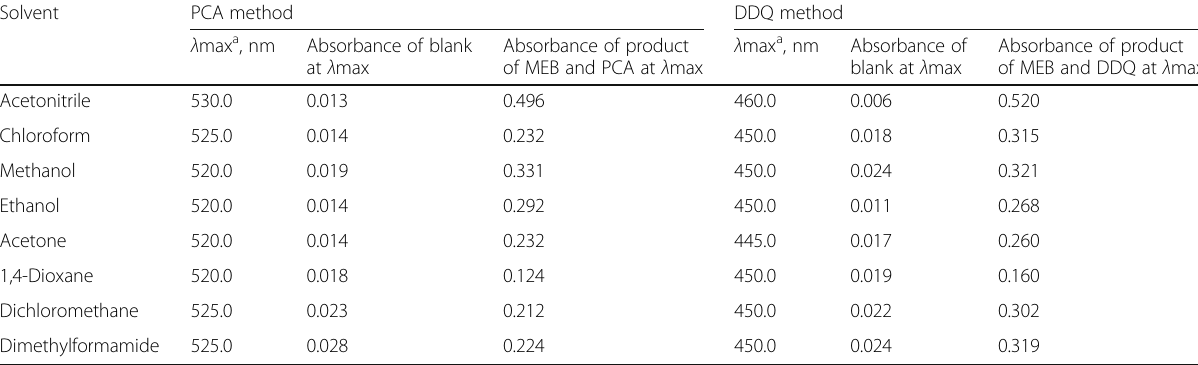
Table 1 Results showing the effect of solvents on the absorbance of C-T complexes when 160 and 32 μ g mL -1 MEB used in the reaction in PCA and DDQ methods, respectively